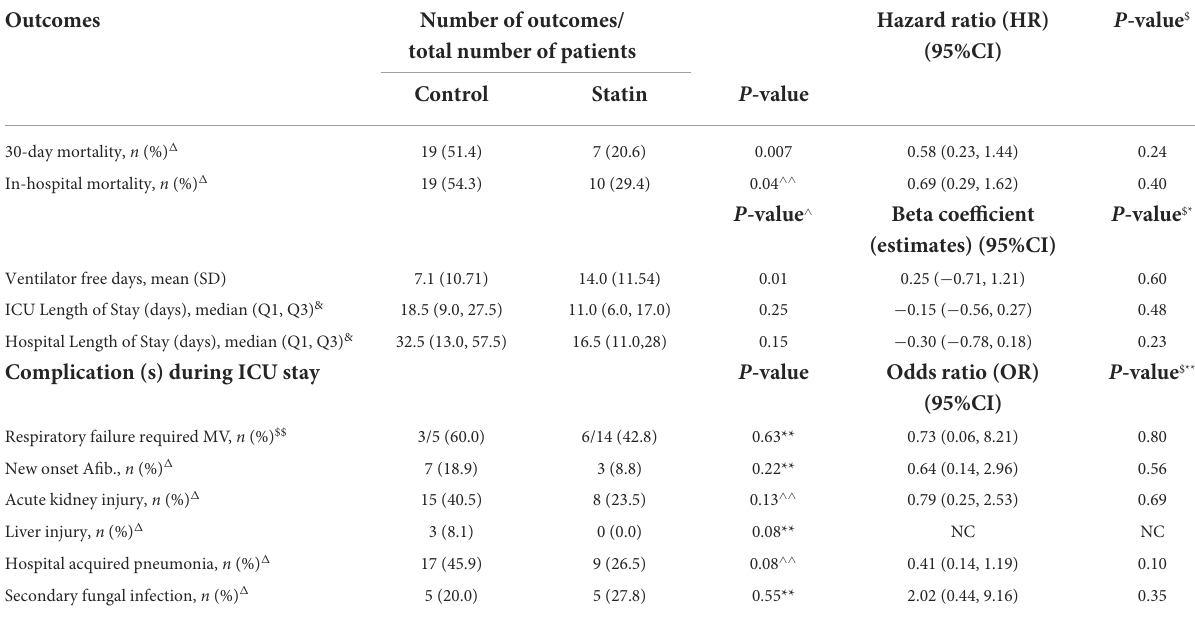
TABLE 3 Subgroup analysis—regression analysis for the outcomes after PS adjustment (new initiation of